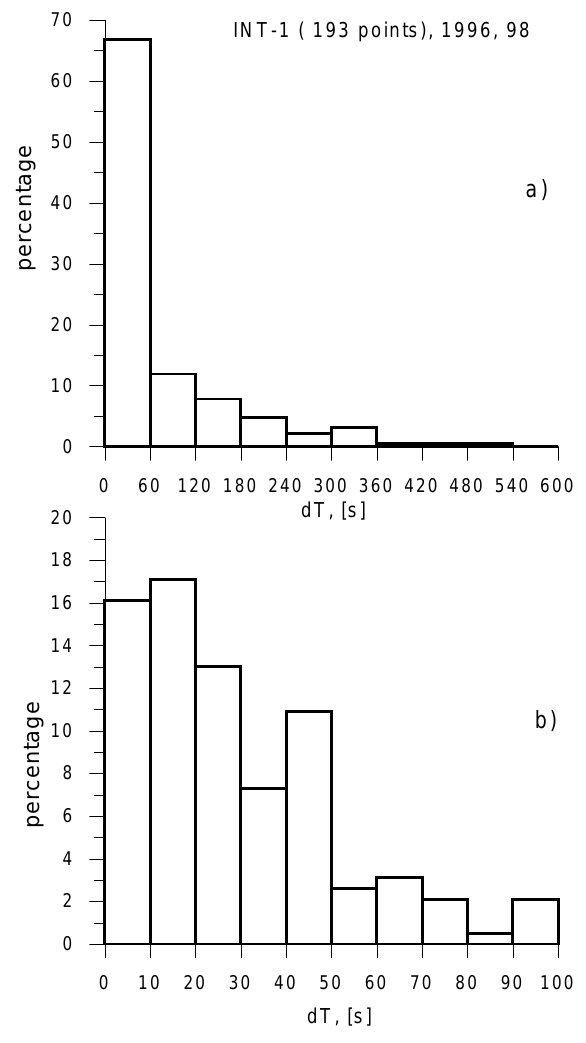
Fig. 5. Distribution of the transition time of pressure changes.